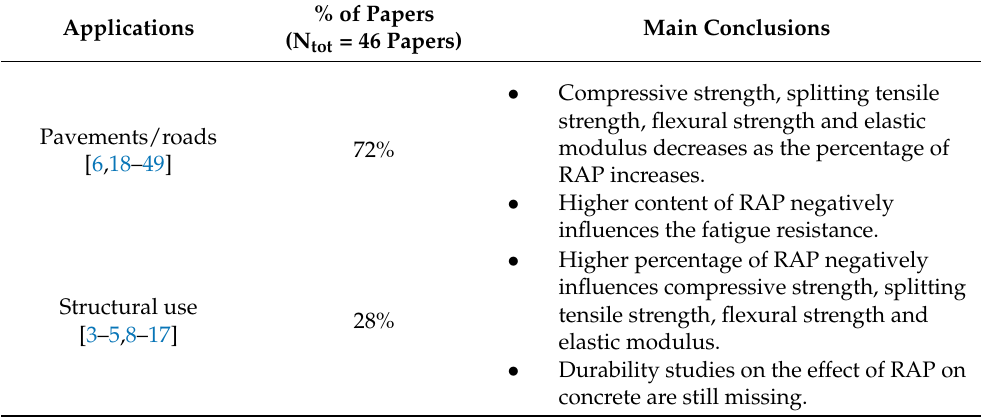
Table 1. Use of RAP in different fields and the main research